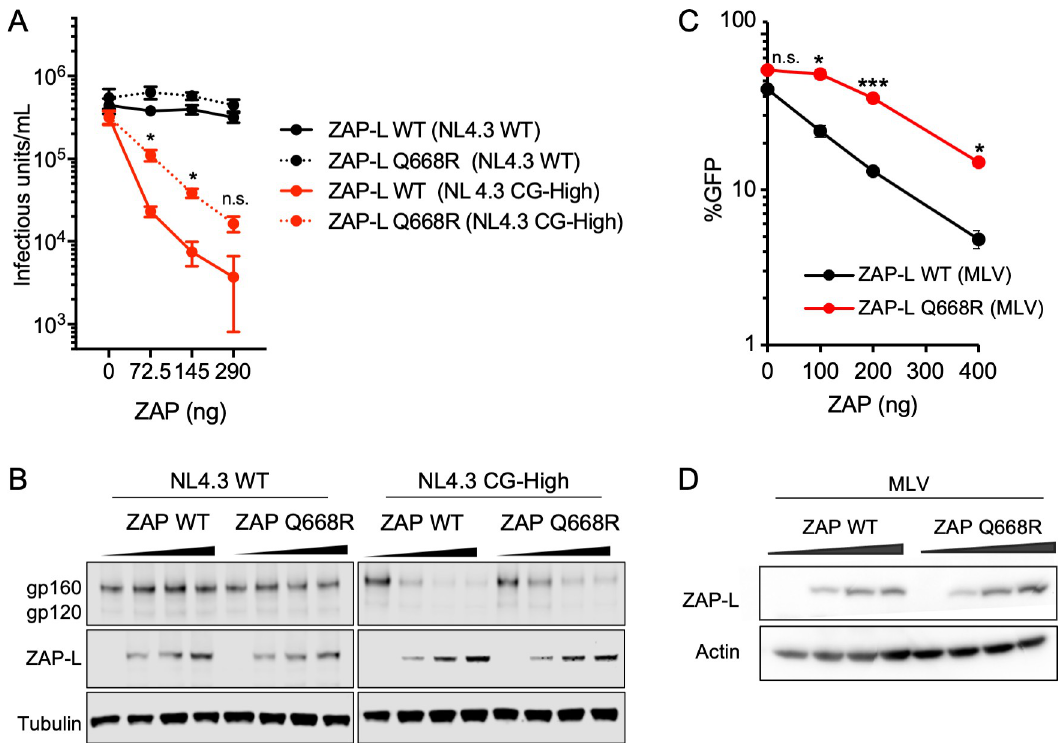
Fig 8. Antiviral potency of ZAP-L is reduced by the Q668R mutation. (A) HEK 293T ZAP -/- TRIM25 -/- cells were transfected with a provirus of either HIV-1 (NL4.3 WT) control or a CpG-enriched mutant (NL4.3 CG-High), together with a plasmid encoding TRIM25 and increasing concentrations of a plasmid encoding WT ZAP-L or the ZAP-L Q668R mutant. After 48 hours, produced virus was harvested, filtered and titered. (B) Immunoblots of whole cell lysates showing expression levels of HIV-1 proteins (gp160 and gp120) and ZAP-L. Tubulin was used as loading control. Results are representative of two independent experiments. (C) The same experiment as in A was performed with MLV. (D) Immunoblots of whole cell lysates showing ZAP-L expression levels from plasmids co-transfected with MLV. Actin was used as loading control. � , p < 0.05; ��� , p < 0.001; ns, not significant.